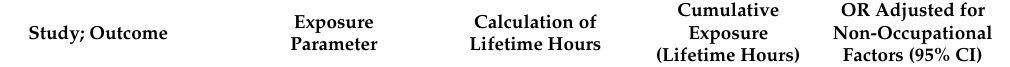
Table 3. Working with the hands at or above shoulder